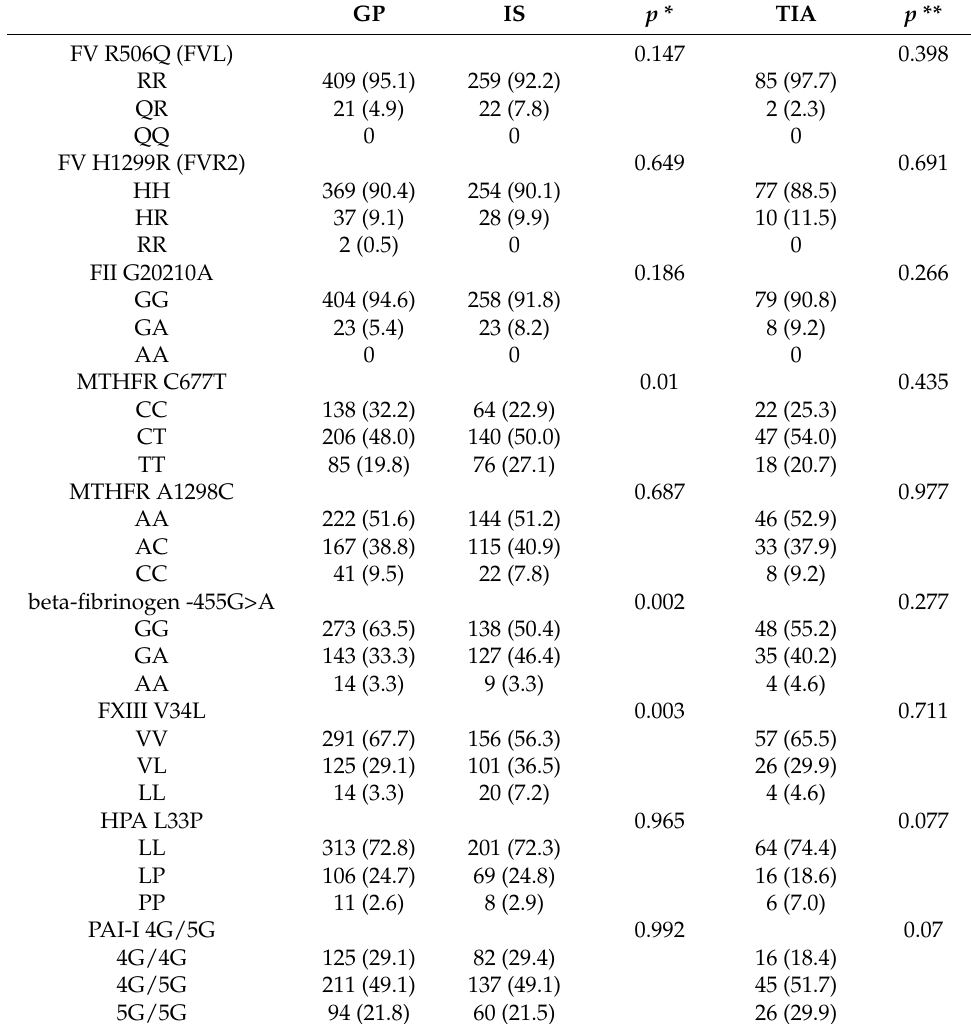
Table 3. Genotype frequency, n and (%) of the nine gene variants. Comparison between ischemic stroke (IS, n = 282) or transient ischemic attack (TIA, n = 87) versus the general population (GP, n =